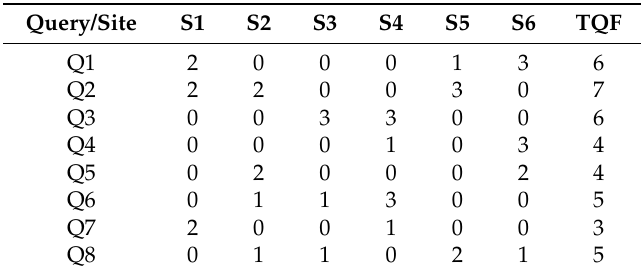
Table 5. Query frequency matrix